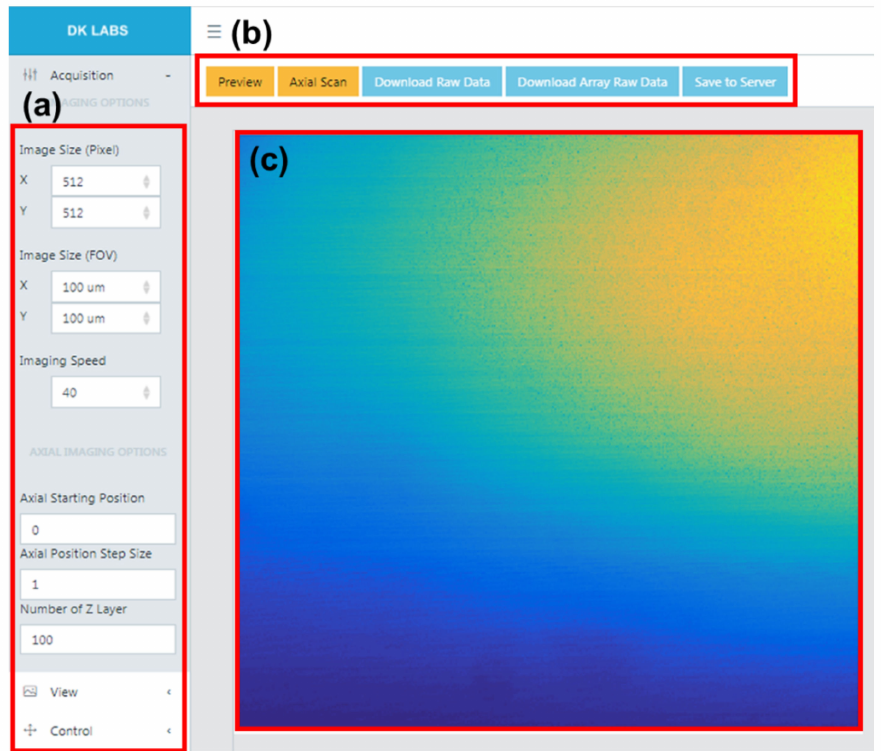
Figure A5. The user interface of the equipment operation page: ( a ) parameter-setting panel; ( b ) operation button panel; and ( c ) result image panel.